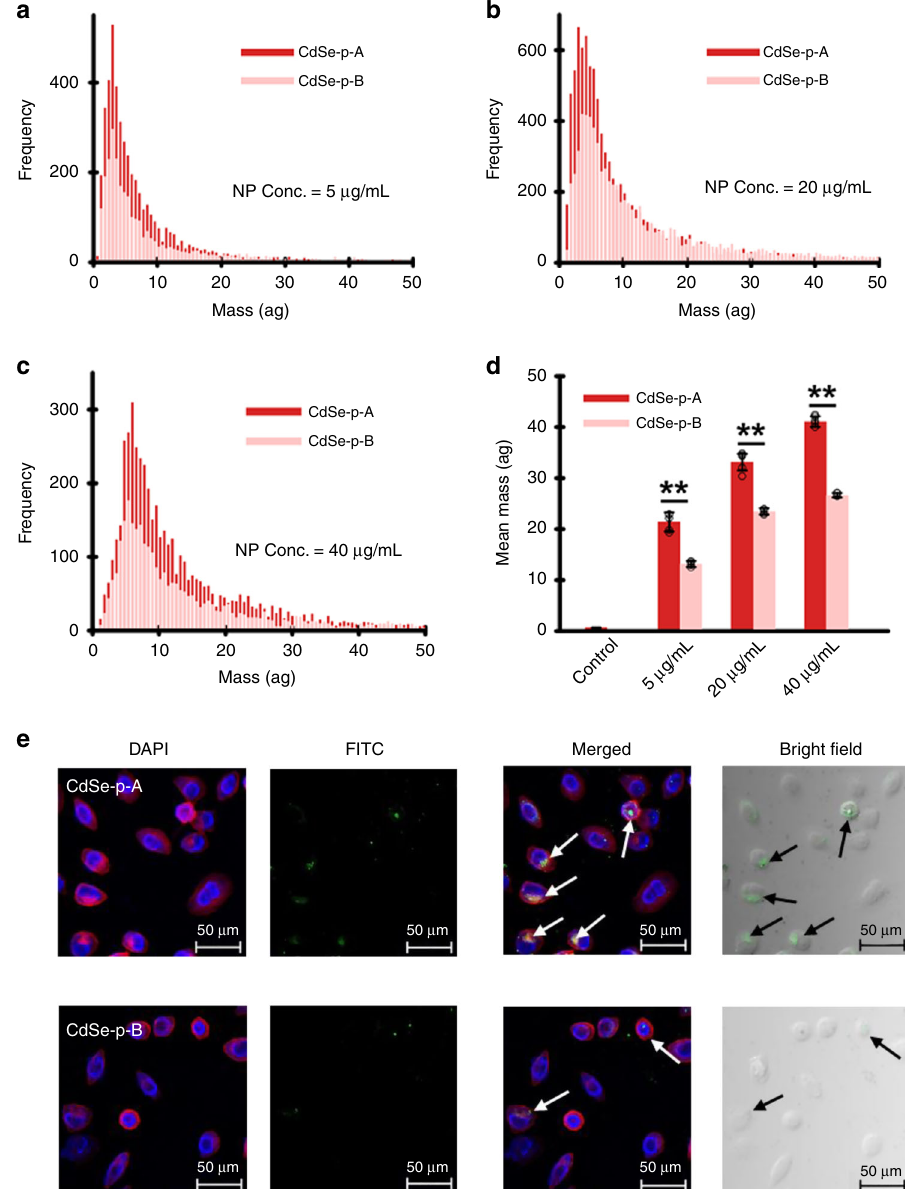
Fig. 3 Facet-dependent binding of transferrin and cellular uptake of CdSe nanoparticles. a – d Single-cell – inductively coupled plasma – mass spectrometry (SC – ICP – MS) histogram of mass distribution ( a – c ) and mean mass ( d ) of CdSe nanoparticles (CdSe-p-A: dark red bar; CdSe-p-B: light red bar) taken up by HeLa cells, after cell incubation with transferrin – CdSe conjugates for 3 h. Results show higher cellular content of nano-Cd in HeLa cells exposed to “ A ” materials (i.e., CdSe with more (100) facet) that preferentially bound with transferrin. Data are presented as mean ± SD of fi ve replicate samples ( n = 5; p = 0.0007, 0.0004, <0.0001 for the group of 5, 20, 40 µ g/mL CdSe nanoparticles by one-way ANOVA, respectively). e Confocal laser scanning microscopy images of HeLa cells after incubated with FITC-labeled transferrin – CdSe conjugates demonstrated greater cellular uptake of “ A ” materials. Microscopic analysis was independently repeated fi ve times, and the results were similar. Statistical signi fi cance between groups: (**) p < 0.01. Source data are provided as a Source Data fi